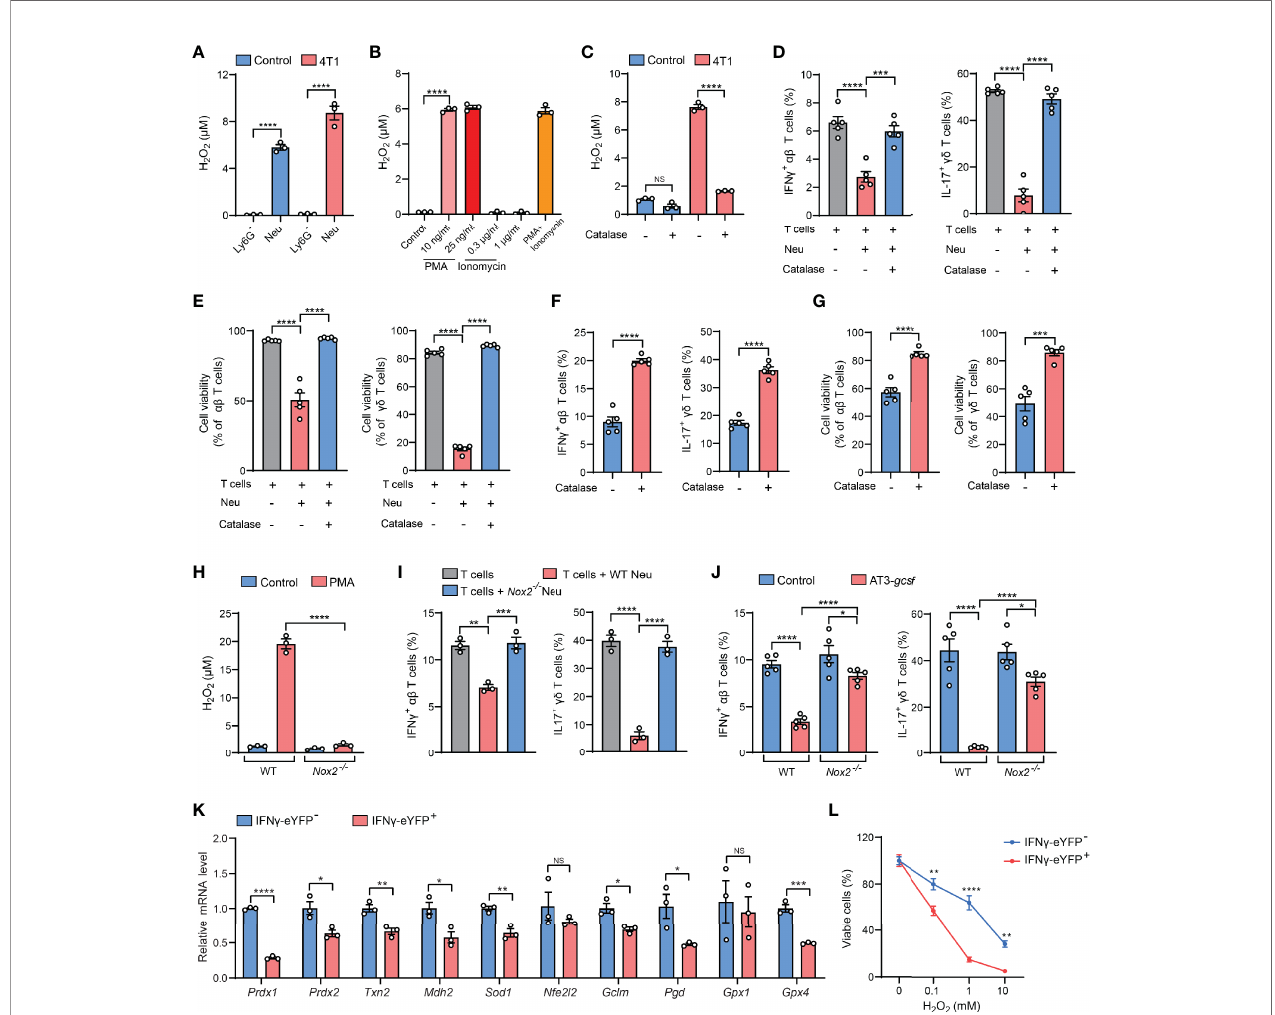
FIGURE 3 | H 2 O 2 is a key mediator of the neutrophil-induced artifact in ICS analysis. (A) H 2 O 2 levels in isolated Ly6G - or Ly6G + lung tissue cells from control or 4T1 tumor-bearing mice (n=3 per group) were measured after ICS stimulation for 30 minutes at room temperature. (B) H 2 O 2 levels in lung neutrophils isolated from 4T1 tumor-bearing mice (n=3) were measured after incubation with the indicated concentrations of PMA or ionomycin or cotreatment with PMA (25 ng/ml) + ionomycin (1 µg/ml) for 30 minutes at room temperature. (C) H 2 O 2 levels in crude lung samples derived from control or 4T1 tumor-bearing mice were measured after ICS stimulation for 30 minutes at room temperature in the absence or presence of catalase (1000 U/ml). (D, E) Puri fi ed naïve mice-derived lung T cells and 4T1 tumor- bearing mice-derived lung neutrophils were mixed together in the absence or presence of catalase (1000 U/ml), and then subjected to ICS analysis. The frequencies of IFN g + ab T cells or IL-17 + gd T cells (D) were quanti fi ed, and the T cell viabilities (E) were determined by Live/Dead Fixable staining. (F, G) Crude 4T1 tumor samples (n=5 per group) were subjected to ICS analysis in the absence or presence of catalase (1000 U/ml). The frequencies of IFN g + ab T cells or IL-17 + gd T cells (F) were quanti fi ed, and the T cell viabilities (G) were determined by Live/Dead Fixable staining. (H) H 2 O 2 levels in isolated Ly6G + lung tissue cells from WT or Nox2 -/- AT3- gcsf tumor-bearing mice were measured after PMA (25 ng/ml) stimulation for 30 minutes at room temperature. (I) Puri fi ed naïve mice-derived lung T cells were mixed with lung neutrophils derived from WT or Nox2 -/- AT3- gcsf tumor-bearing mice, and the frequencies of IFN g + ab T cells or IL-17 + gd T cells were quanti fi ed by ICS (n=3). (J) ICS analysis of the frequencies of IFN g + ab T cells or IL-17 + gd T cells in crude lung samples from WT or Nox2 -/- AT3- gcsf tumor-bearing mice (n=5 per group). (K) Relative mRNA levels of the indicated antioxidant genes were compared between IFN g - and IFN g + lung ab T cells isolated from IFN g -eYFP mice (n=5). (L) Susceptibility of IFN g - and IFN g + lung ab T cells, isolated from IFN g -eYFP mice (n=3), to the indicated concentration of H 2 O 2 for 2 hours. Values of n represent biologically independent animals. Data are mean ± s.e.m. P values were calculated using unpaired t -test (F, G, K) or one-way ANOVA (A-E, H – J) or two-way ANOVA (L) . * P < 0.05; ** P < 0.01; *** P < 0.001; **** P < 0.0001. NS, not signi fi